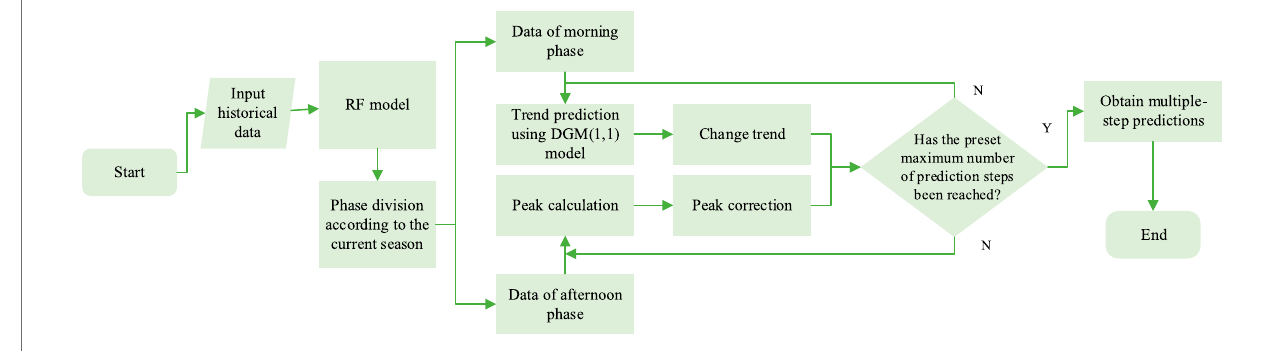
FIGURE 2 | Improved stochastic forest model process.